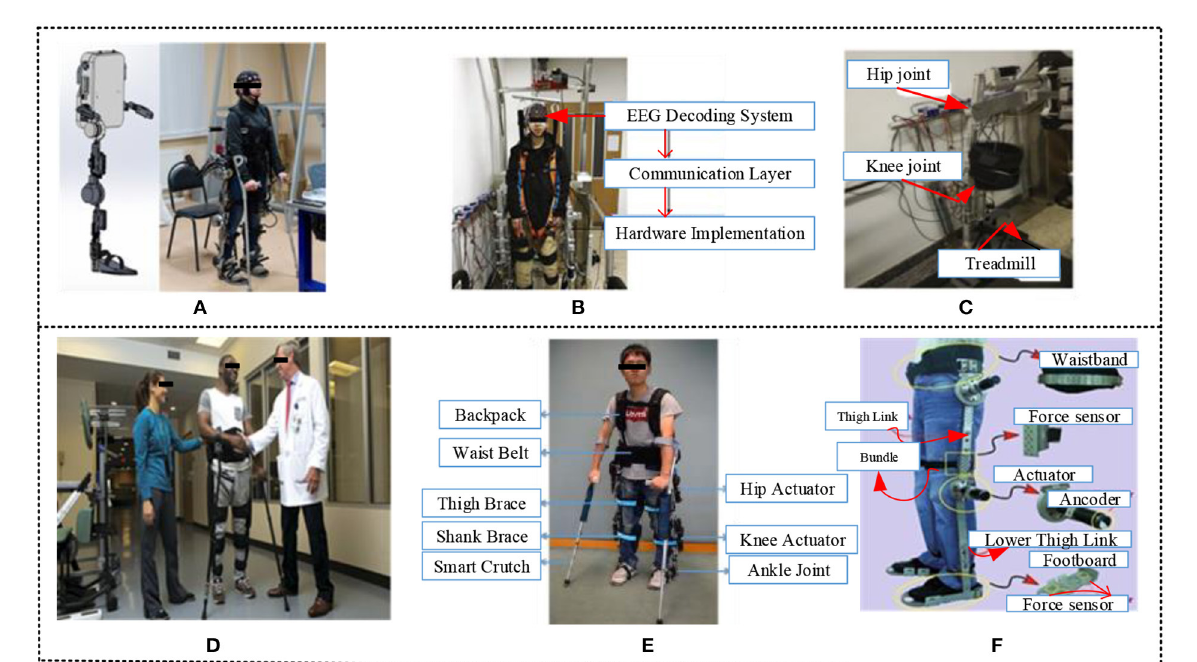
FIGURE1 (A) Laboratory setup of the lower-limb exoskeleton integrated with mHMI. The monitoring system commands the drives to carry out the needed motions while examining the measurements from the sensors to control the effectiveness of the set motions. The movement can be achieved by controlling information from the EMG and EEG data classifiers (Gordleeva et al., 2020). (B, C) Lower limb exoskeleton by the School of Automation Science and Electrical Engineering, Beihang University, Beijing. An HRI loop was introduced, where the information features of the user were decoded and regulated to enhance BCI outcomes. At the same time, position feedback was incorporated into the mechatronics structure (Liu D. et al., 2017). (D) Lower extremity exoskeleton by the Human Motion and Control Business Unit of Parker Hannifin, with